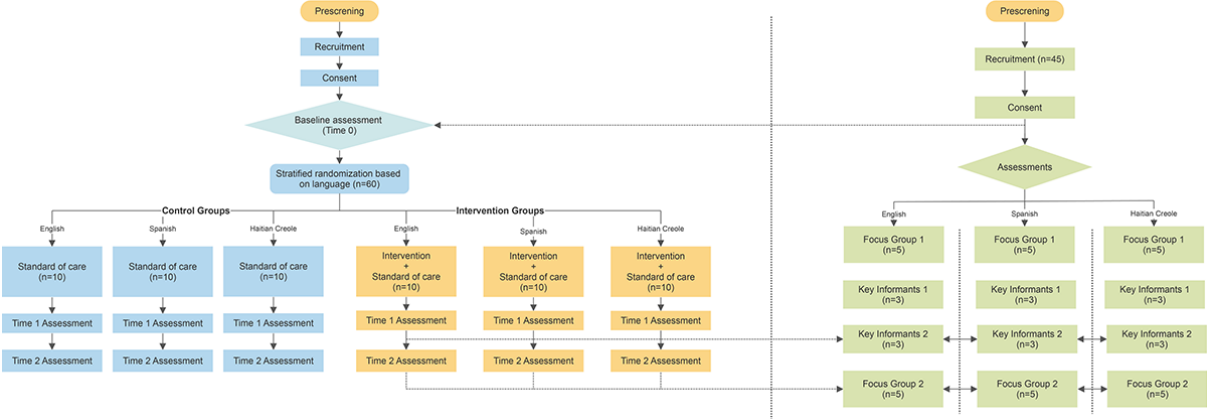
Figure 2. Data flow diagram for the study quantitative components (left) and the qualitative components